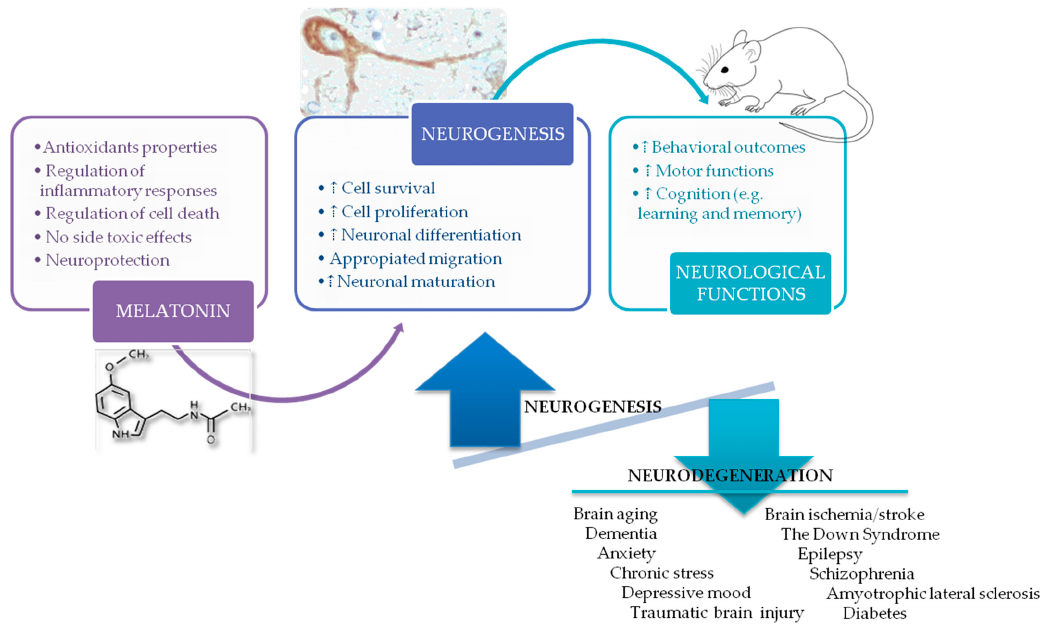
Figure 3. Melatonin may positively impact several neurological outcomes by correcting impairments that affect neurogenesis in the adult brain under different neuropathological conditions.